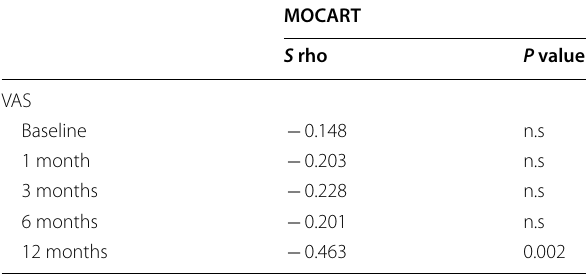
Data are calculated using the Spearman’s rank-order